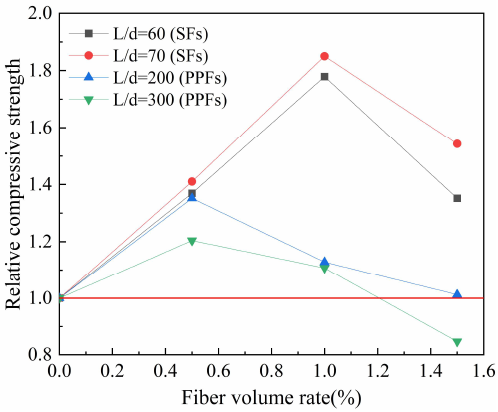
Figure 14. The effect of fiber aspect ratio on compressive strength.